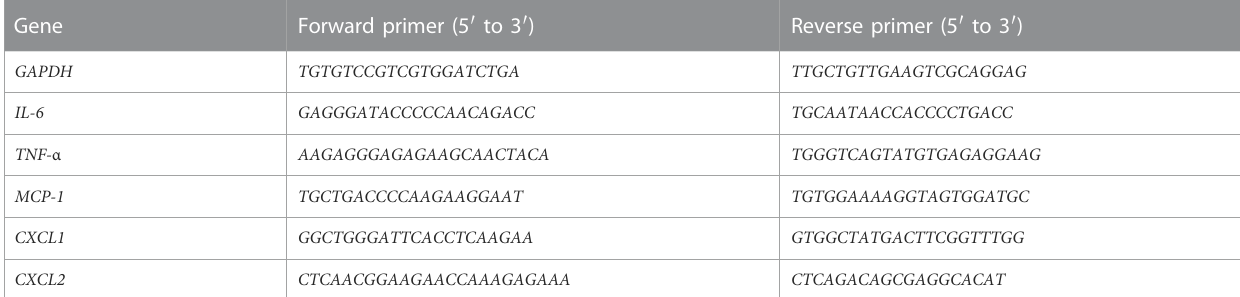
TABLE 2 The primer sequences for qPCR.